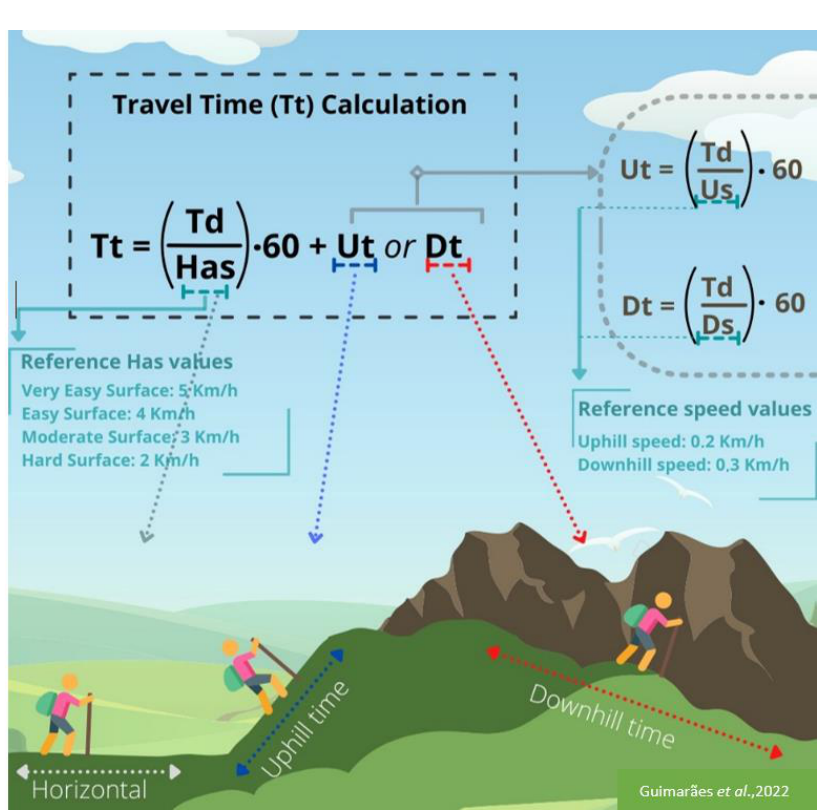
Figure 5. Schematic summary for calculating the Travel Time (Tt). Legend: Td: Traveled Distance; Has: Horizontal Average Speed; Ut: Uphill Time; Dt: Downhill Time; Us: Uphill Speed; Ds: Downhill Speed. Source: Research Collection [13].